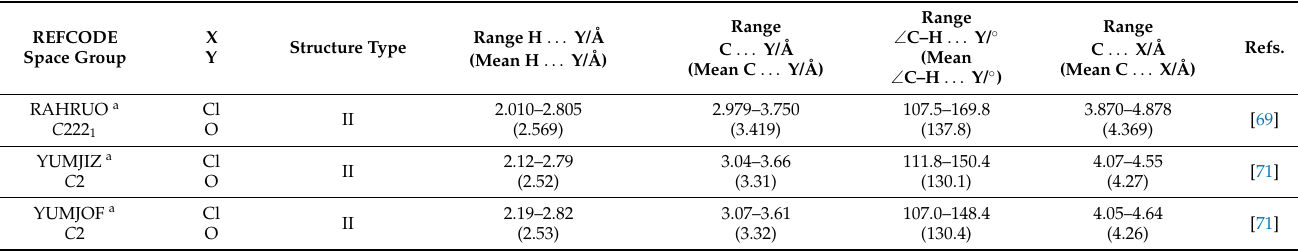
Table 4. Structure Type II motifs with [ClO 4 ] –